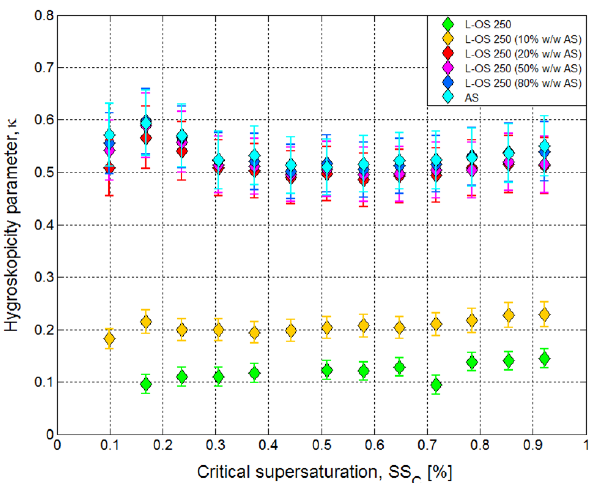
Figure 7. Hygroscopicity parameter, κ , derived from the CCN mea- surements, as a function of SS c for six mixtures of L-OS 250 and AS. Error bars represent an estimated uncertainty of 10% on κ and uncertainty on the SS c is estimated to be 5% / % as described in Sect.